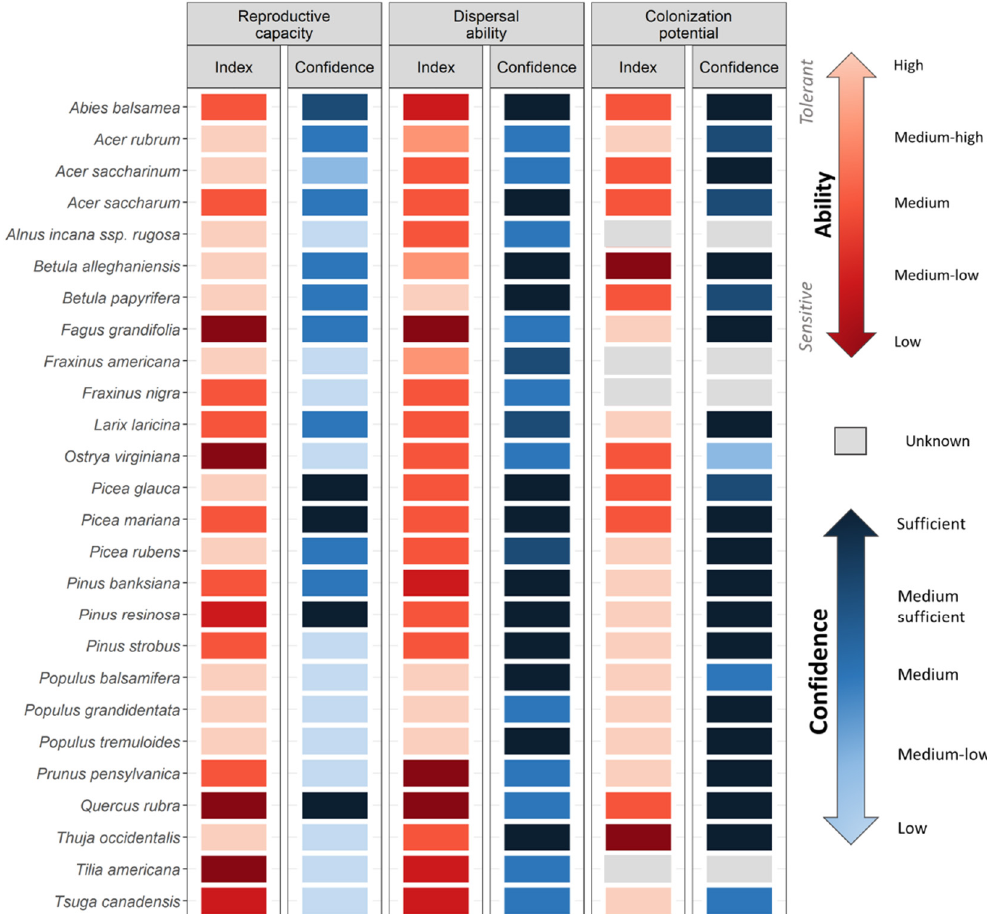
Figure 3. Tree species ability to track shifts in suitable climate conditions, as considered using three main strategies that influence migration: Reproductive capacity , Dispersal ability and Colonization potential . Each index ranks the relative ability (from low / sensitive to high / tolerant, reds) of tree species for a specific strategy (see Scheme 2 for which mechanisms / traits were considered). Confidence associated with available data is also presented, as ranked from low to sufficient (blues). Species for which no data was available were considered as Unknown (grey). For more details on definitions and ranking, see Table S2.